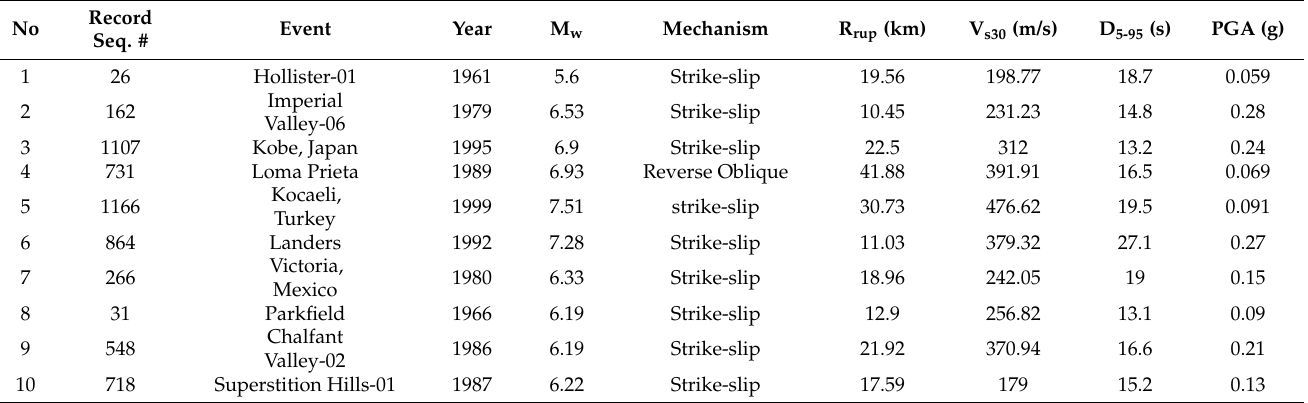
Table 7. List of the selected ground motions.